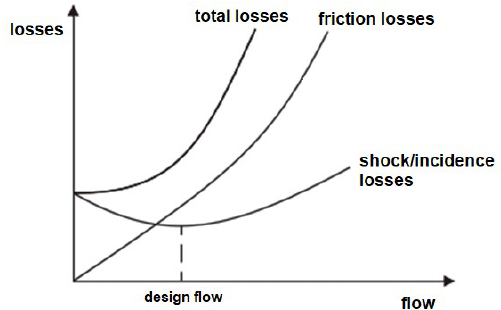
Figure 1. Identification of hydraulic losses in a pump as turbine (PAT).